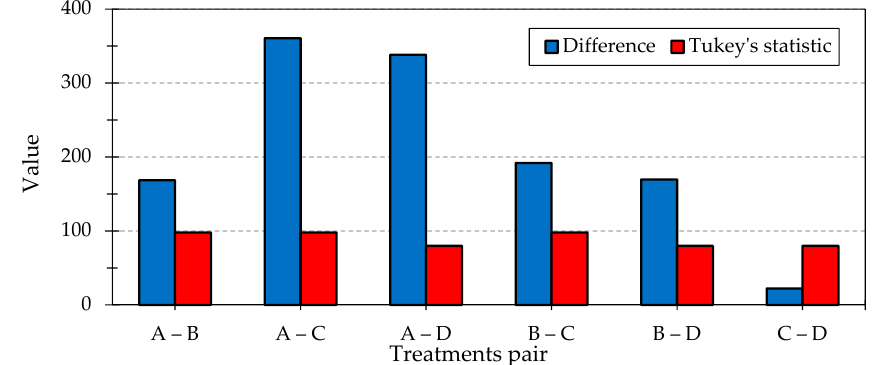
Figure 10. The comparison between the absolute difference between the means and the Tukey’s statistic for the six significant pairs of treatments.